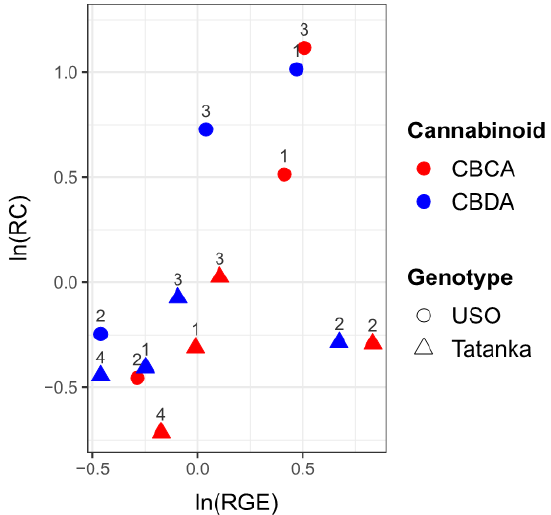
Figure 6. The values of ln(RC) are plotted against the values ln(RGE). The number above the points indicates the number of the given sample. A positive correlation between ‘RC’ values and ‘RGE’ values can be values can be observed. Table 4. Regression coefficient estimates, standard errors, and p -values from LTS fit to cannabinoid relative concentration on relative gene expression (both in log-scale) with cannabinoid type and genotype as covariates. The p -values that denote the statistical significance are in bold. Variable